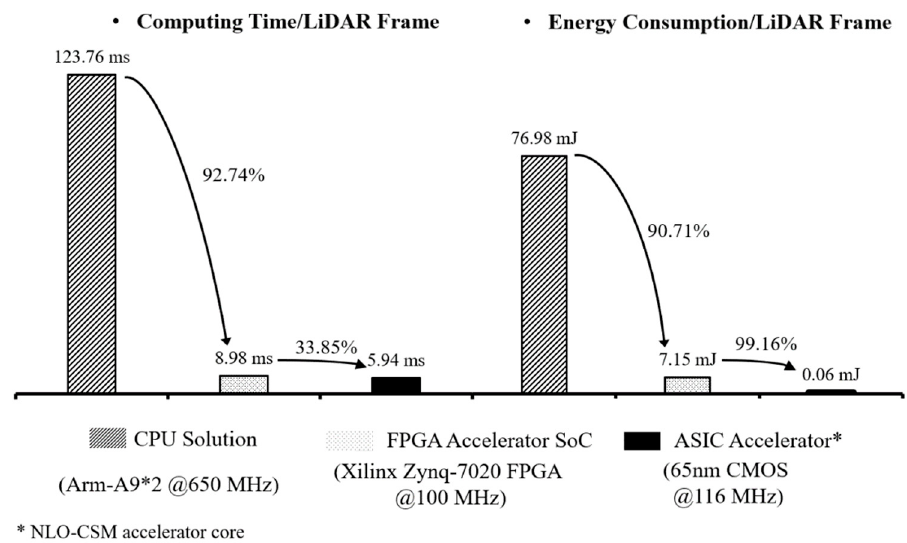
Figure 17. Comparison of computing time and energy consumption, per LiDAR frame, among the CPU software solution, FPGA hardware accelerator core, and ASIC accelerator core of the NLO- CSM